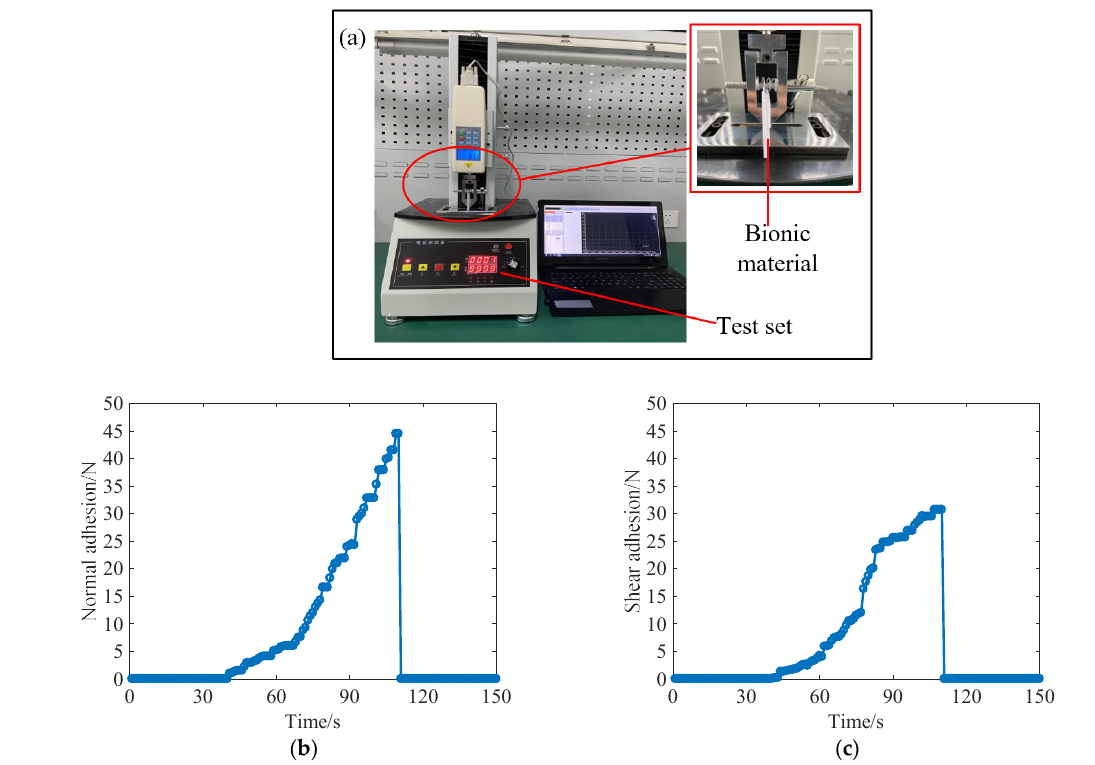
Figure 9. The test set to measure the adherence force. ( a ) The test set for measuring the adherence force of the bio-inspired materials. ( b ) The test set to measure the normal force of the adhesive materials. ( c ) The shearing force of the adhesive materials without preload.